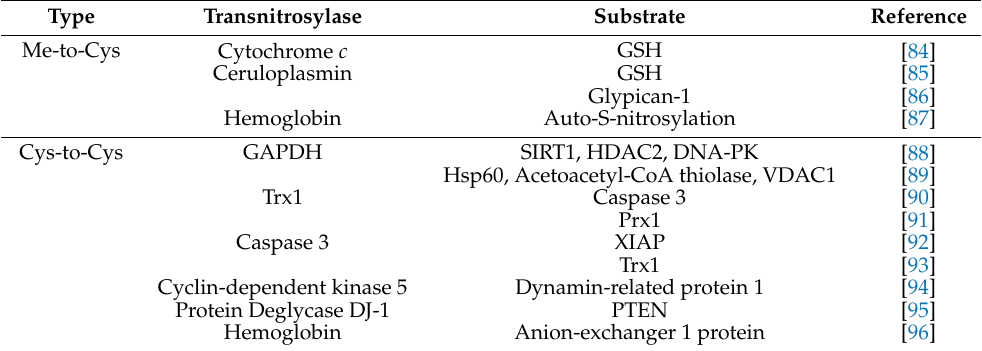
Table 2. Transnitrosylases and their